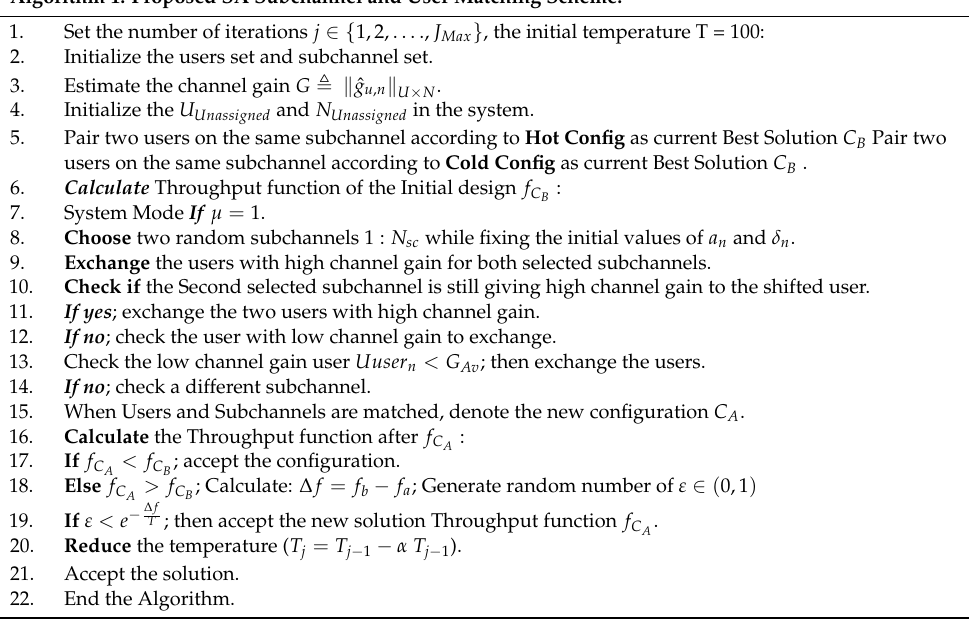
Algorithm 1: Proposed SA Subchannel and User Matching